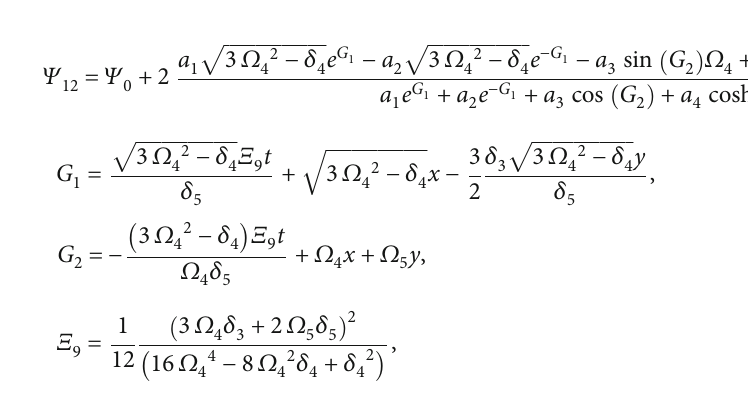
p ffiffiffiffiffiffiffiffiffiffiffiffiffiffiffiffiffiffiffiffi 3 Ω 42 − δ